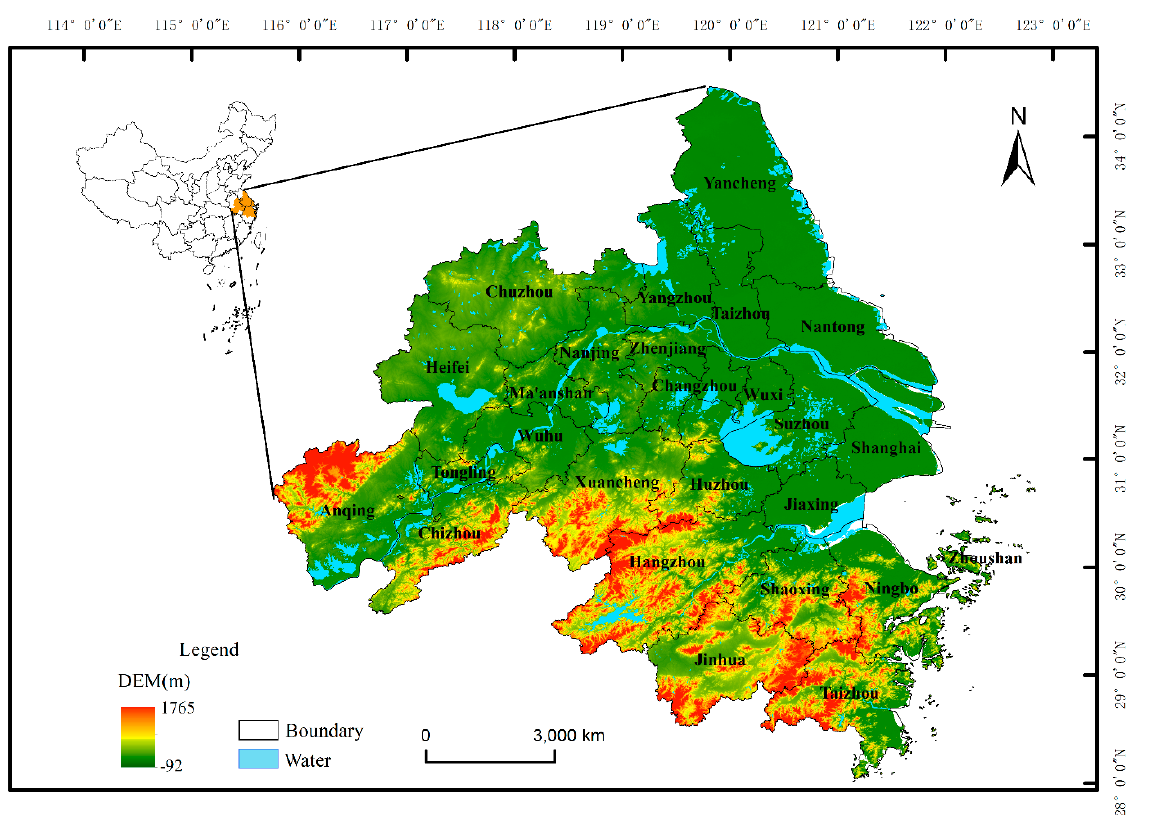
Figure 1. The location of the Yangtze River Delta Urban Agglomeration. Table 1. The data source of five ecological